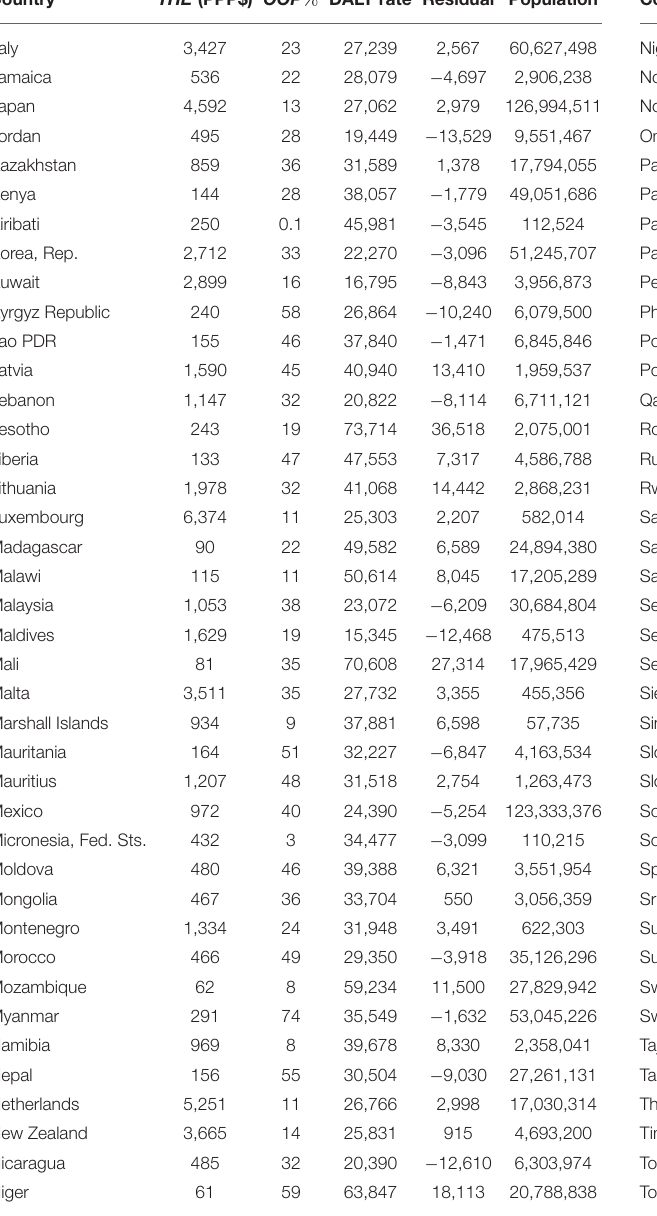
TABLE 14 | Estimated residuals for each country (Nigeria to Tonga).